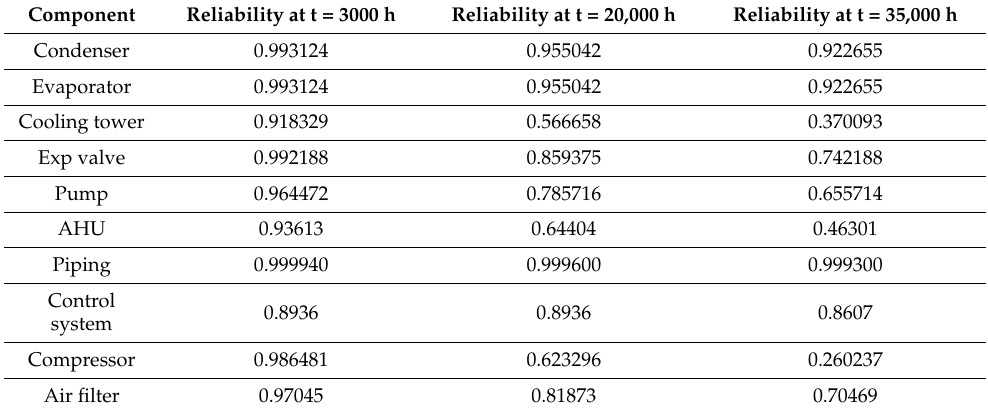
Table 6. List of the components’ reliability at three different operating times.